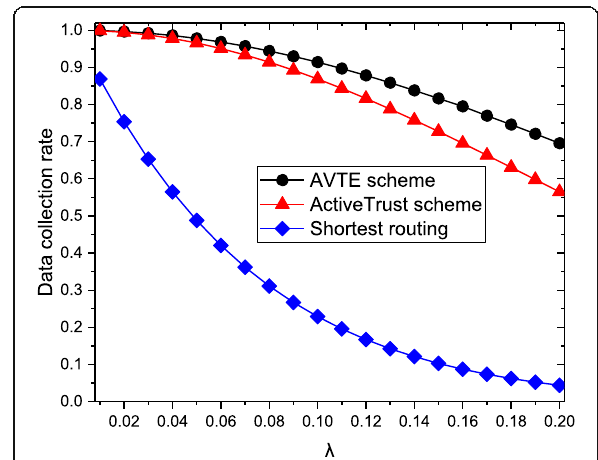
Fig. 14 The data collection rate of the three schemes